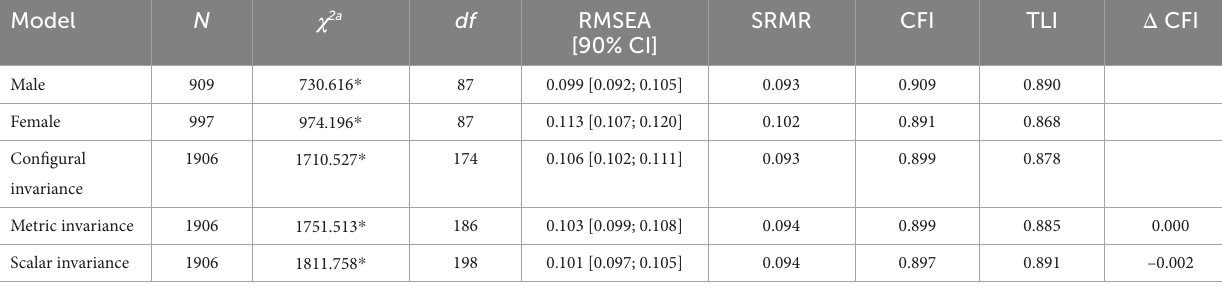
TABLE 3 Fit indices for single CFAs and measurement invariance models across gender. Model